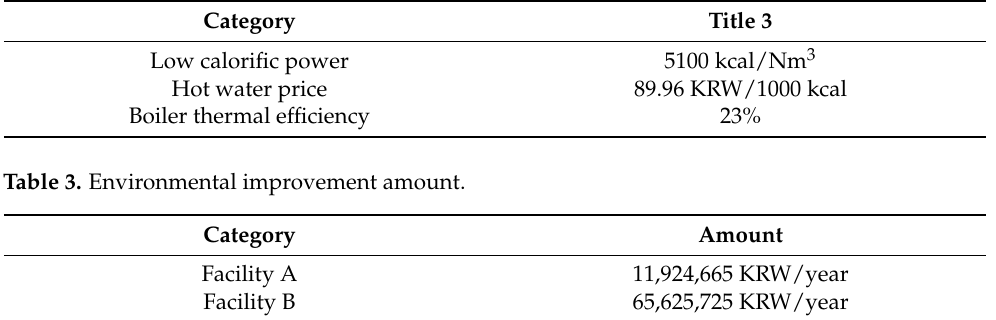
Table 3. Environmental improvement amount.